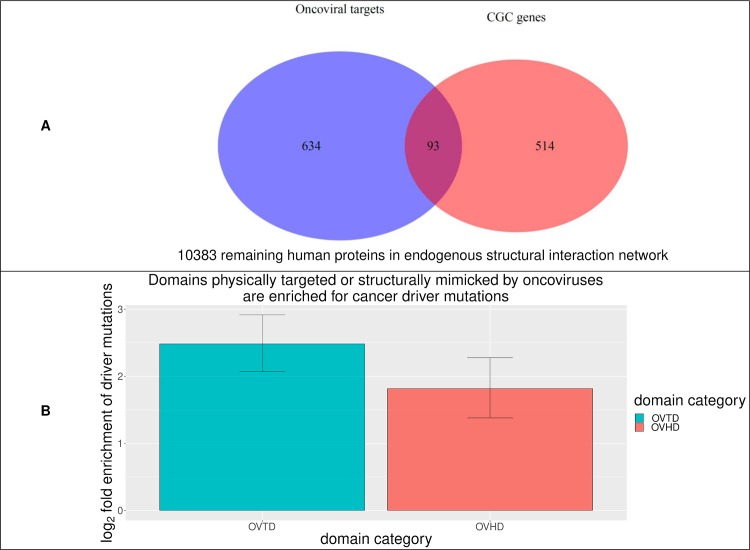
Oncovirus-targeted proteins are enriched for driver proteins, and oncovirus-targeted or mimicked domains are enriched for driver mutations.(A) There is a 3-fold enrichment of Cancer Gene Census proteins in oncovirus-targeted proteins. (B) There are 5-fold and 3-fold enrichments of driver mutations in oncovirus-targeted domains (OVTDs) and oncoviral homology domains (OVHDs), respectively.